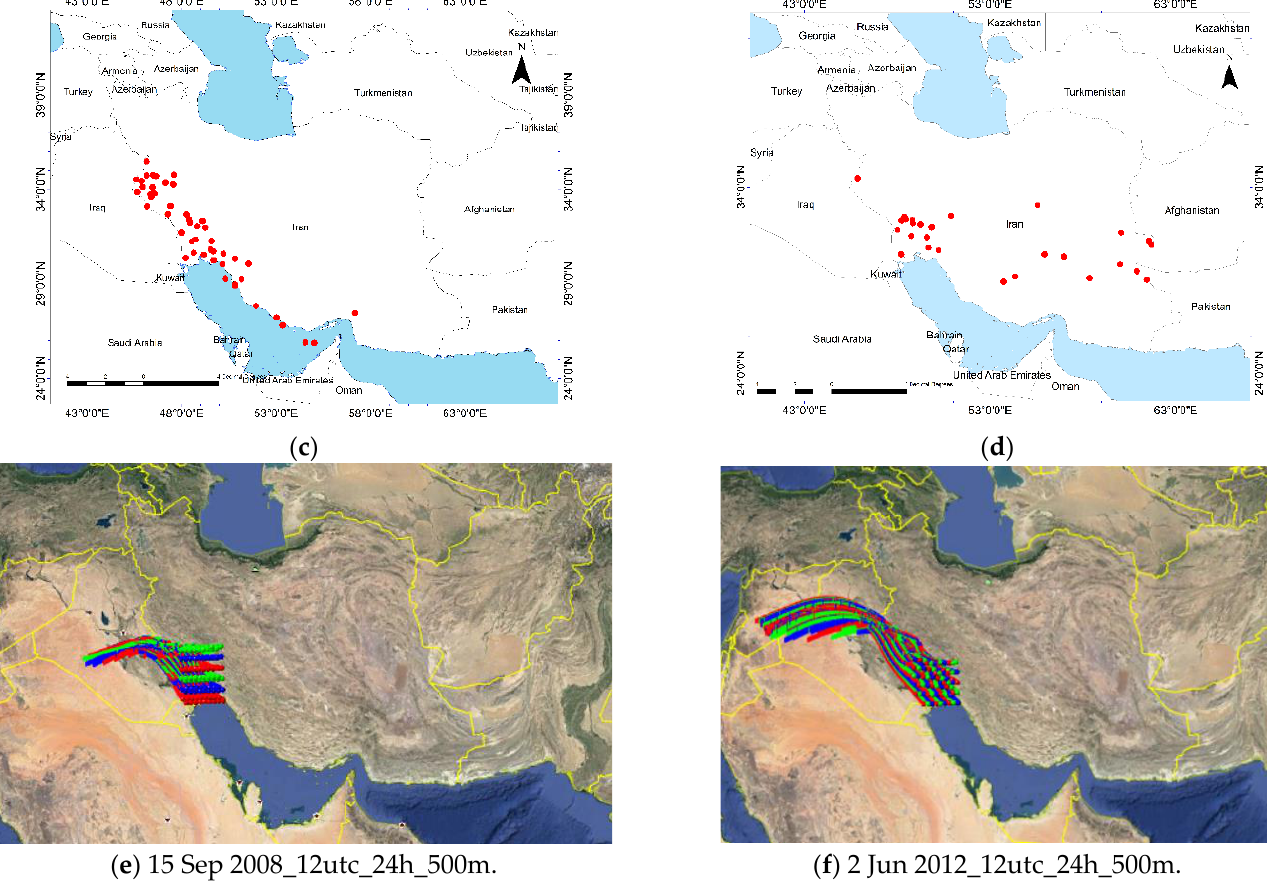
Figure 7. Measured 𝑃𝑀 10 concentrations in three air monitoring stations in west and SW Iran on ( a ) 14 – 17 September 2008 and ( b ) 1 – 3 June 2012. Visibility reported under 1 km at several stations in Iran taken from dust-related weather codes on ( c ) 14 – 17 September 2008 and ( d ) 1 – 3 June 2012. One-day backward trajectory matrix from the HYSPLIT model for air masses at 500 m heights affected the southwest of Iran on ( e ) 15 September 2008 and ( f ) 2 June 2012.